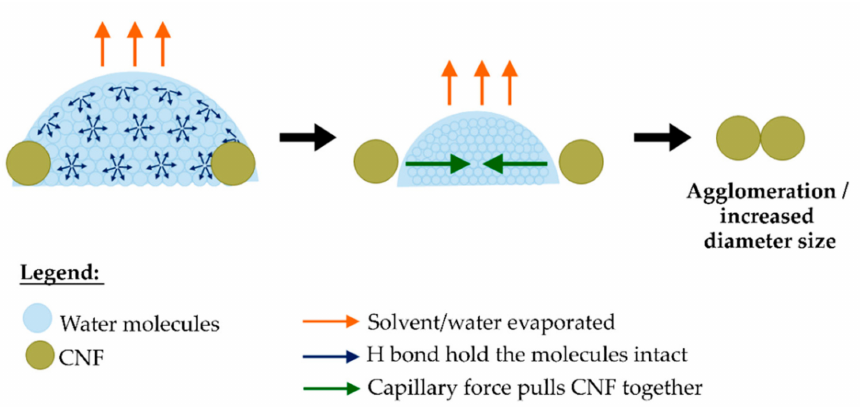
Figure 7. Schematic representation of CNF drying in bionanocomposites blending